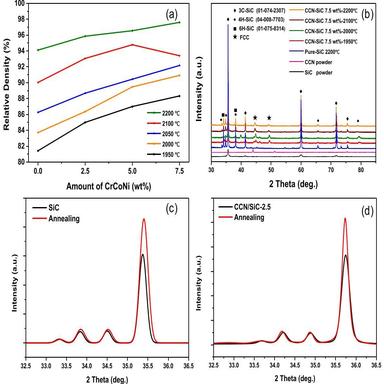
Relative density and XRD pattern of SiC/CCN/SiC composites: (a) relative density, (b) XRD pattern of raw powder, sintered SiC and CCN/SiC composites, (cd) XRD pattern of SiC and CCN/SiC-2.5 sintered at 2200℃ before and after annealing, respectively.